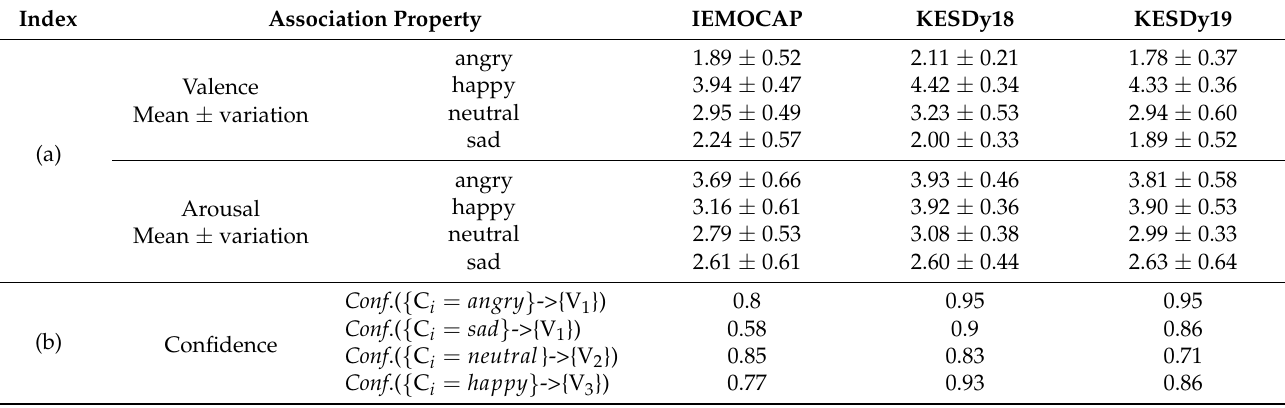
Table 1. Association properties of discrete emotion labels and valence-levels in multi-domain SER datasets: ( a ) Mean and standard variation of arousal and valence levels on a five-point scale for each discrete emotion category; ( b ) Confidence of discrete emotion labels and valence-level of three-point